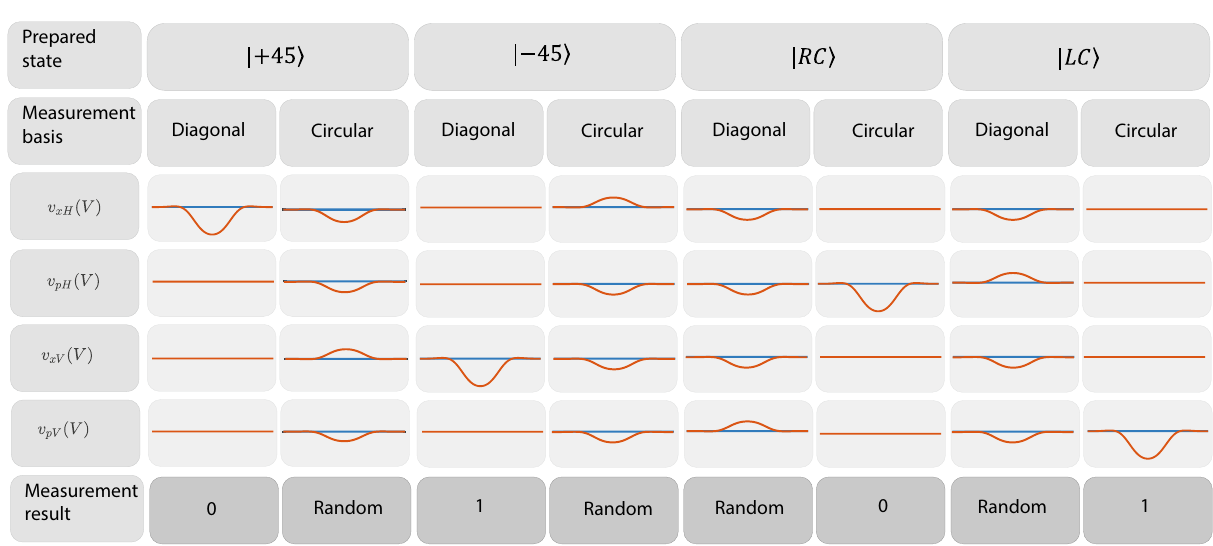
Figure 3. Representative schematics for the voltages at TIA’s output in Fig. 1 for each of the four prepared states considering one of the two measurement basis, and the corresponding bit measurement